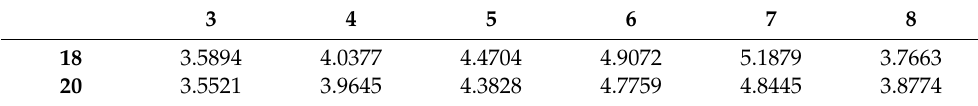
Table 6. The ef f ( j , k ) value of the Biorthogonal Spline family (wavelet length 18–20).